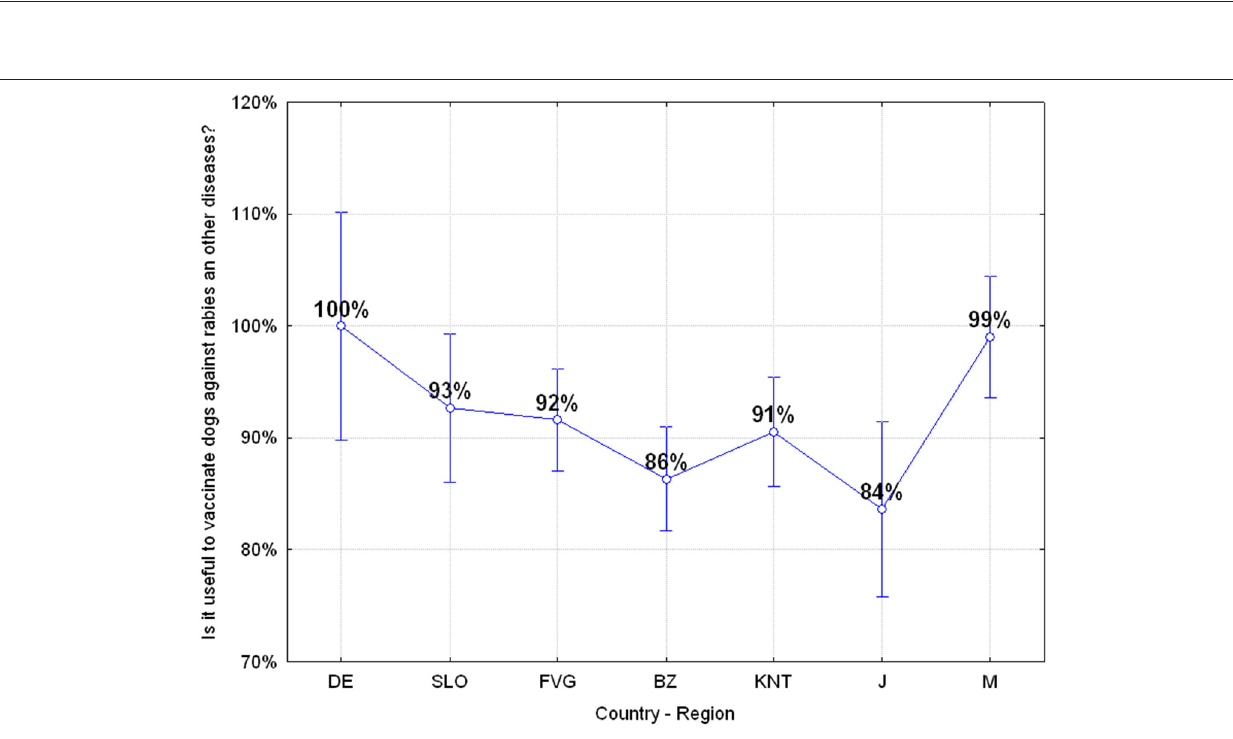
FIGURE 7 | Q21: “Is it useful to vaccinate dogs against rabies and other diseases?” ANOVA F (6,649) p = 0.00482 [Axes X regions or countries, Axes Y % correct answers–DE, Germany; SLO, Slovenia; FVG, Friuli Venezia Giulia Italy; BZ, Autonomous Province of Bolzano Italy; KNT, Carinthia Austria; J, Japan; M, Mauritius–( n =